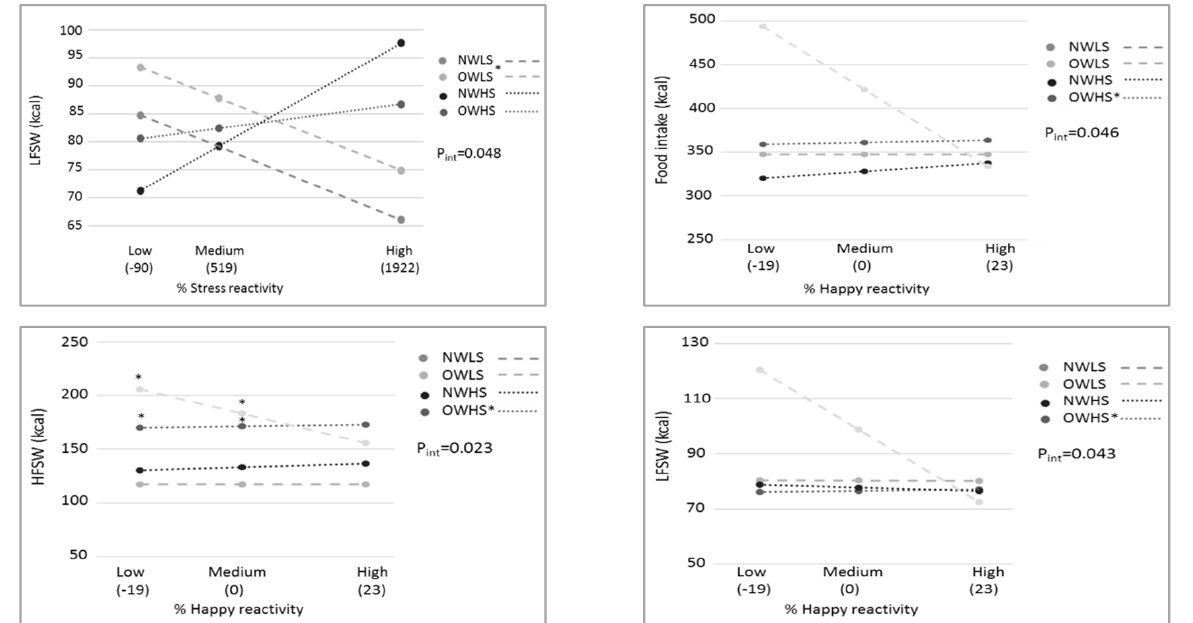
Figure 2. Moderating effects of stress reactivity measures on associations between BMI/stress groups and snack buffet intake after the stressor. * Significant group differences for the stress reactivity versus snack buffet intake relation or for snack buffet intake differences at specific stress reactivity levels, with NWLS as the reference group. P int = p -value of the group × reactivity interaction; NWLS = normal weight low stress; OWLS = overweight low stress; NWHS = normal weight high stress; OWHS = overweight high stress; HF: high fat; LF: low fat; SW: sweet.